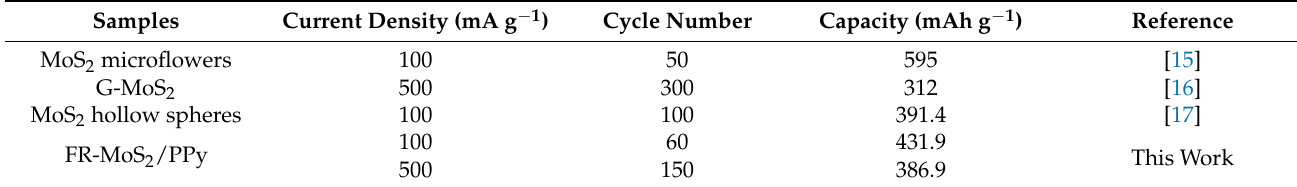
Table 2. Comparison of different MoS 2 anode materials in sodium-ion